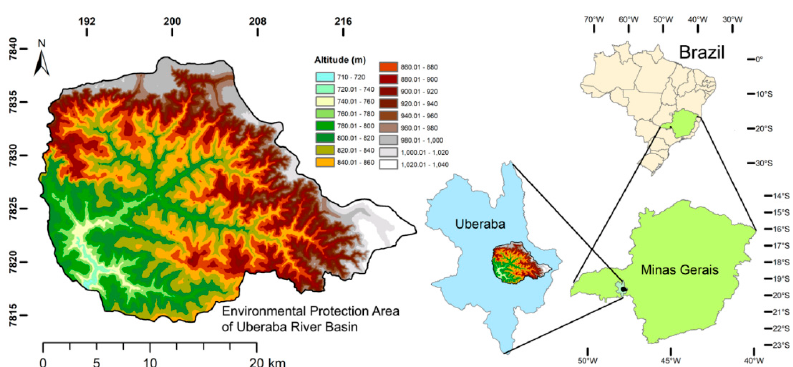
Figure 1. Location of the Environmental Protection Area of Uberaba River Basin in the Uberaba Municipality, State of Minas Gerais, and Brazil. Adapted from Valera et al. [15].